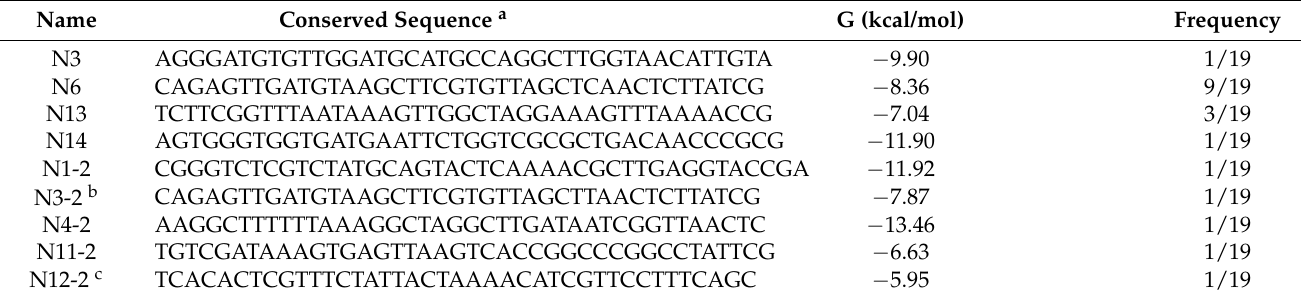
Table 3. Unique Norwalk virus VPg aptamer